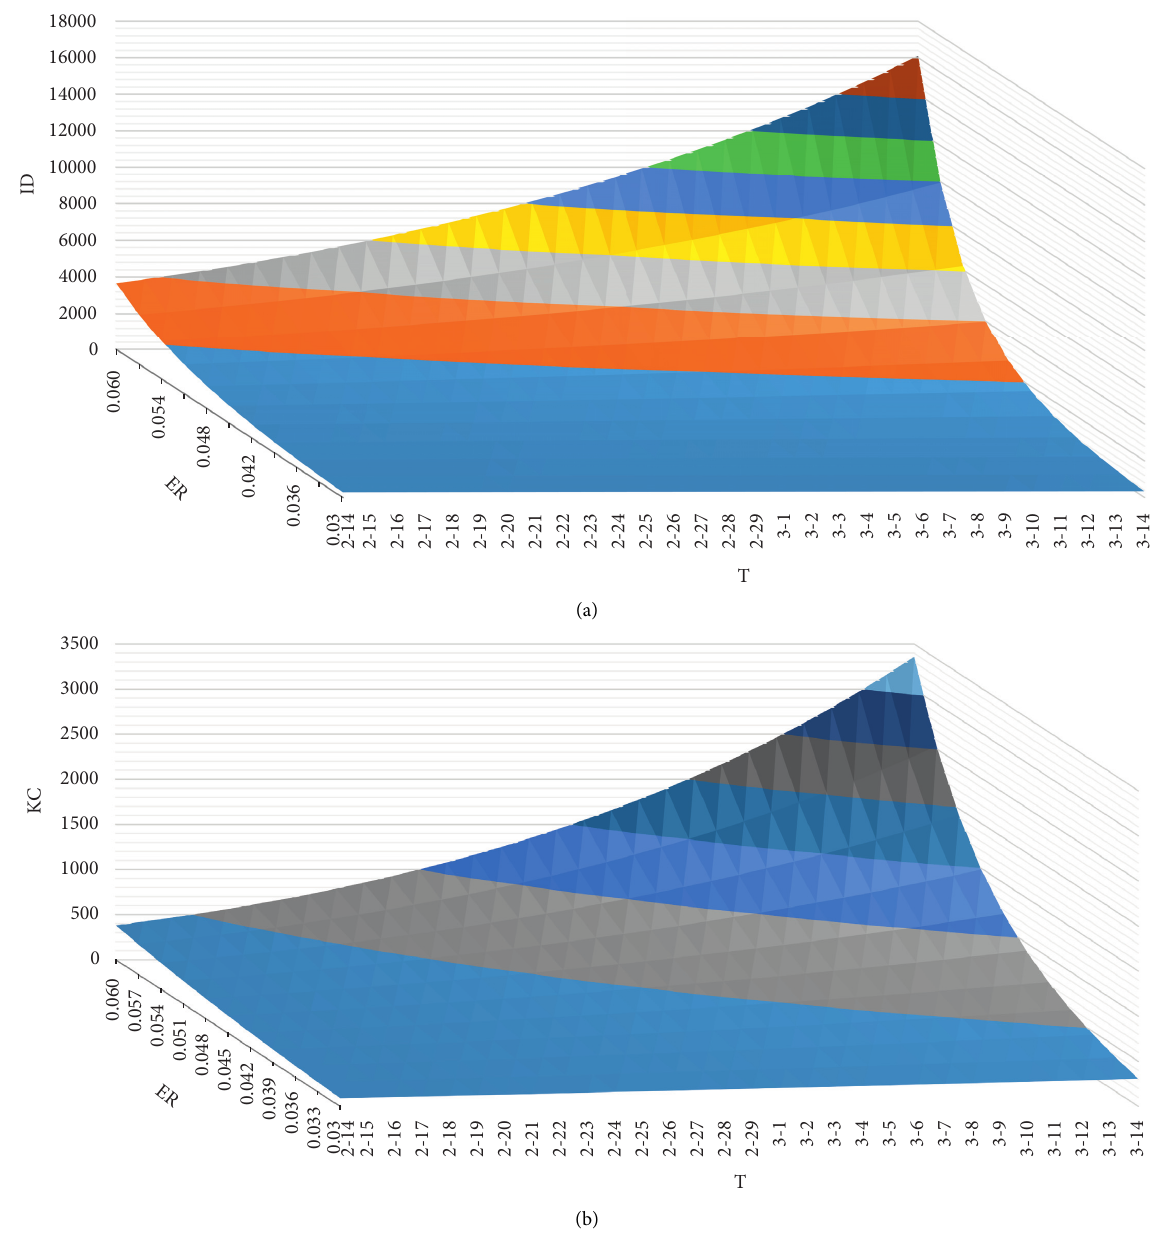
Figure 12: Trend of ID and KC under different